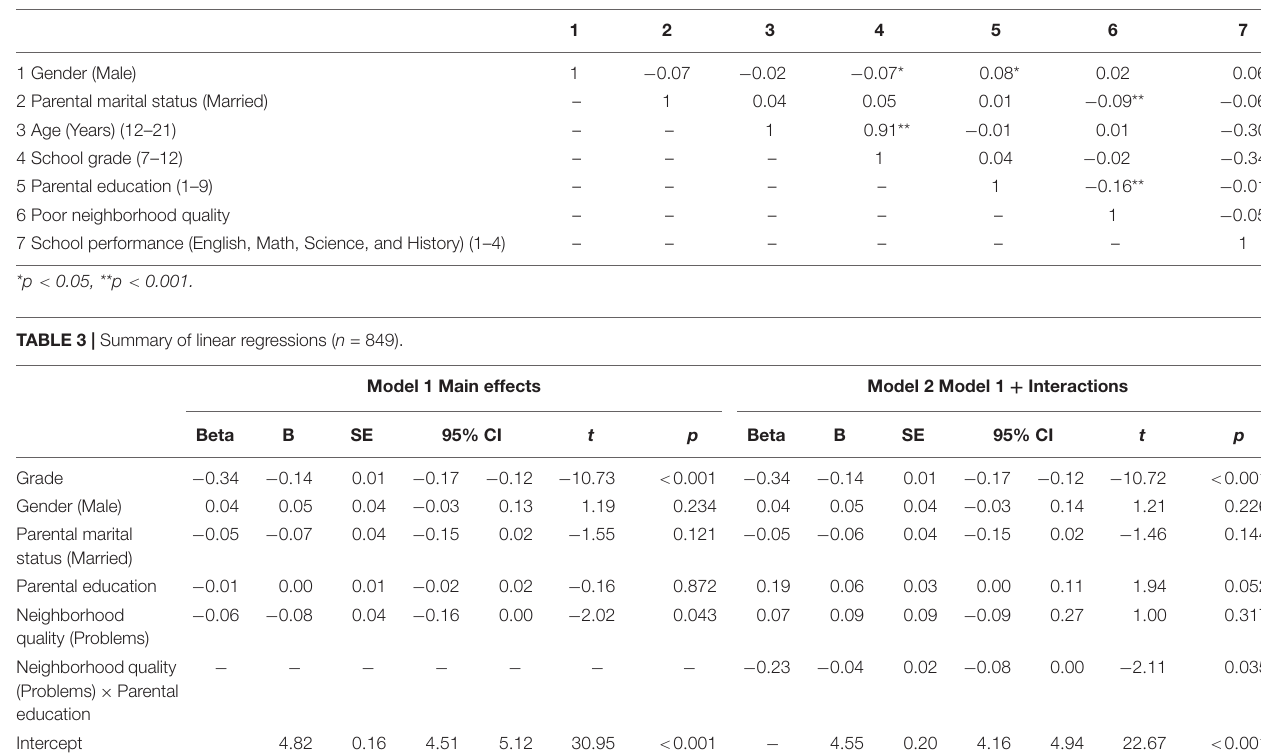
TABLE 2 | Correlation matrix ( n = 849).